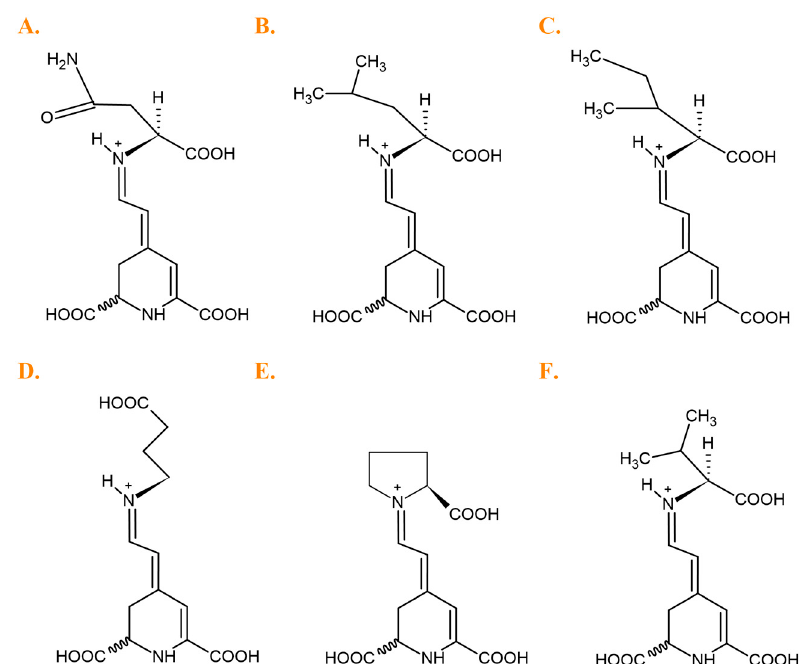
Figure 5. Predominant betaxanthins detected in Beta vulgaris , L. cultivars: ( A ) glutamine-Bx ( 5 ), ( B ) leucine-Bx ( 21 ), ( C ) isoleucine-Bx ( 21' ), ( D ) γ -aminobutyric acid-Bx ( 13 ), ( E ) proline-Bx ( 14 ), ( F ) valine-Bx ( 19 ).